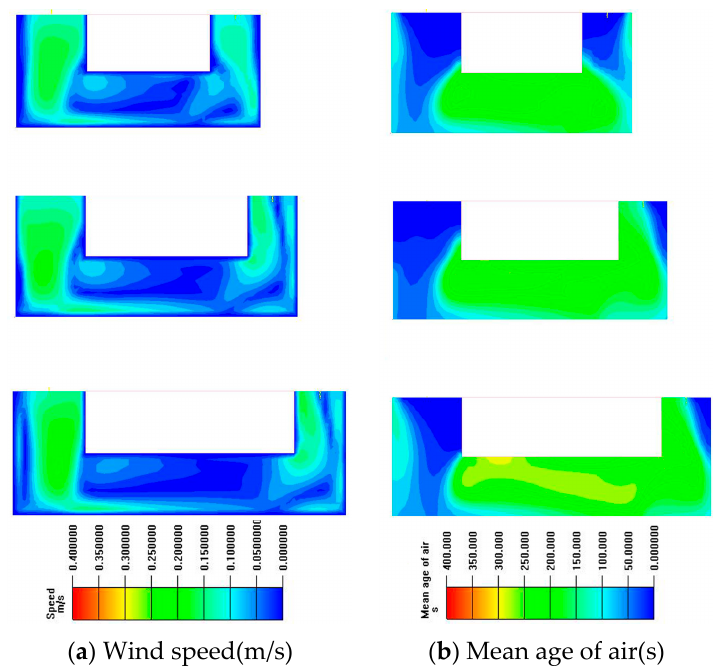
( b ) Wind speed (m/s) ( c ) Mean age of air (s) Figure 6. Comparison of different height of patio. ( a ) Thermal pressure; ( b ) Wind speed ( c ) Mean age of air. With the growth of patio height, more patio floor and the interior wall can be shaded by its higher wall and the bottom of the patio received less solar radiation and became cooler. The temperature between the top and bottom of the patio was enlarged and then the mean thermal pressure difference increased from 2.91 Pa (6 m) to 4.89 Pa (10 m). Conversely, when the height of the patio increased to 8 m, the mean speed of wind became worse from 0.079 m/s to 0.076 m/s and mean age of air rose from 172 s to 184 s, respectively. This is because the solar radiation of the bottom of the patio decreased and the mean temperature in the patio also declined with the increase of height of the patio, resulting in the narrowed indoor ‐ outdoor air density difference. In addition, the narrowed air density exerted a negative influence on stack effect. Eventually, when the height reached 10 m, the mean speed of wind significantly rose to 0.128 m/s and the mean age declined to 133 s. It is obvious that the increase of patio height imposed a significant influence on the stack effect when the height reaches beyond 8 m. Figure 7 illustrates the comparison of stack effect under different lengths of living room (6 m, 8 m, 10 m). Obviously, the whole ventilation performance has made an improvement while the changes are not quite noticeable, as the length of living room decreases. When the length of living room was shortened to 8 m, the mean speed of wind was strengthened from 0.079 m/s to 0.086 m/s and mean age of air declined from 172 s to 149 s. When the length continues to drop to 6 m, the wind speed (0.084 m/s) and age of air (146 s) remained almost the same with ventilation performance